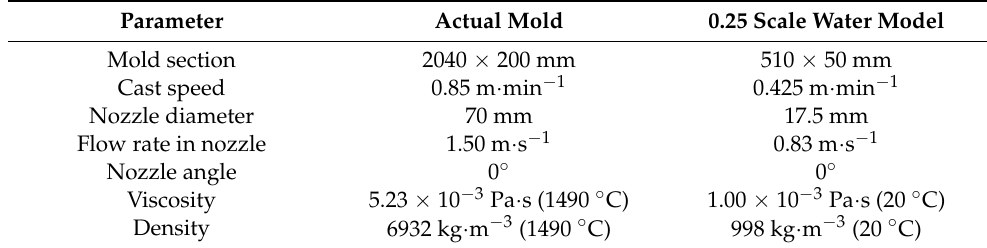
Figure 3. Dimensions and geometries of SEN. Table 2. Parameters of the water model and the corresponding full-scale steel caster.